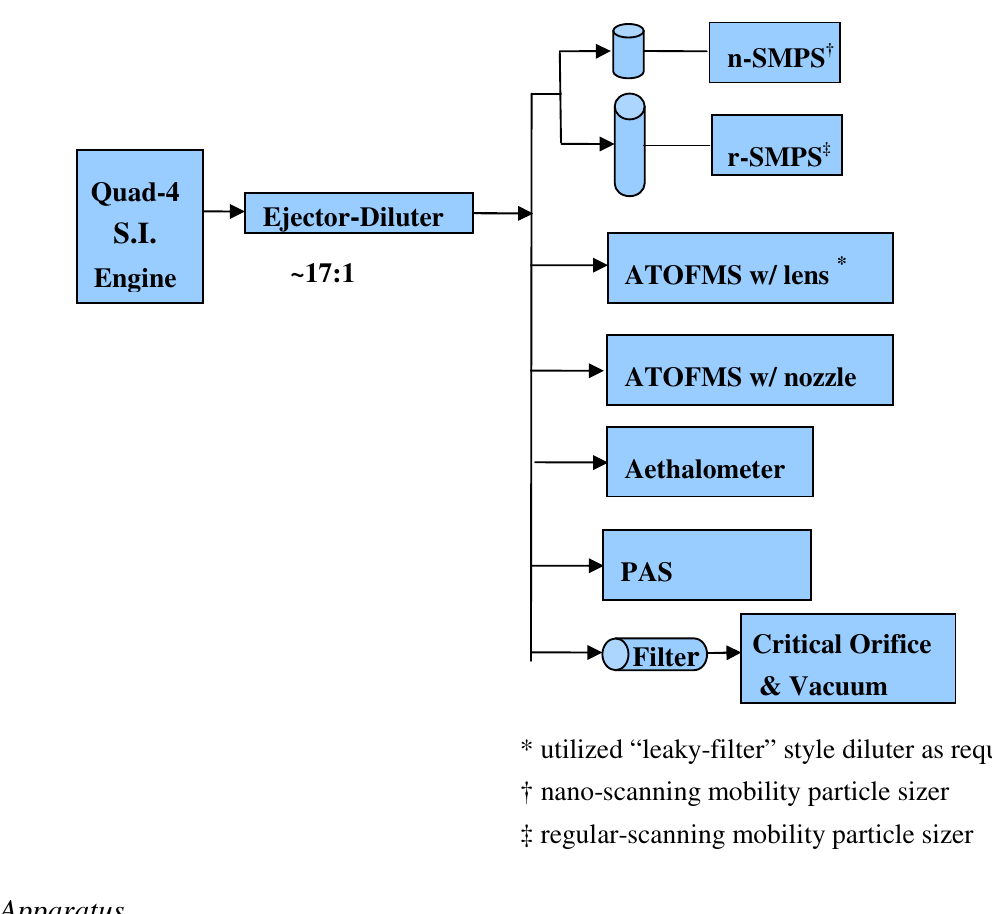
Figure 1. Schematic diagram of the experimental set-up. Appropriate transport flows were provided for all the instruments and secondary dilution was performed for the ATOFMS with the lens inlet to keep concentrations within the operating